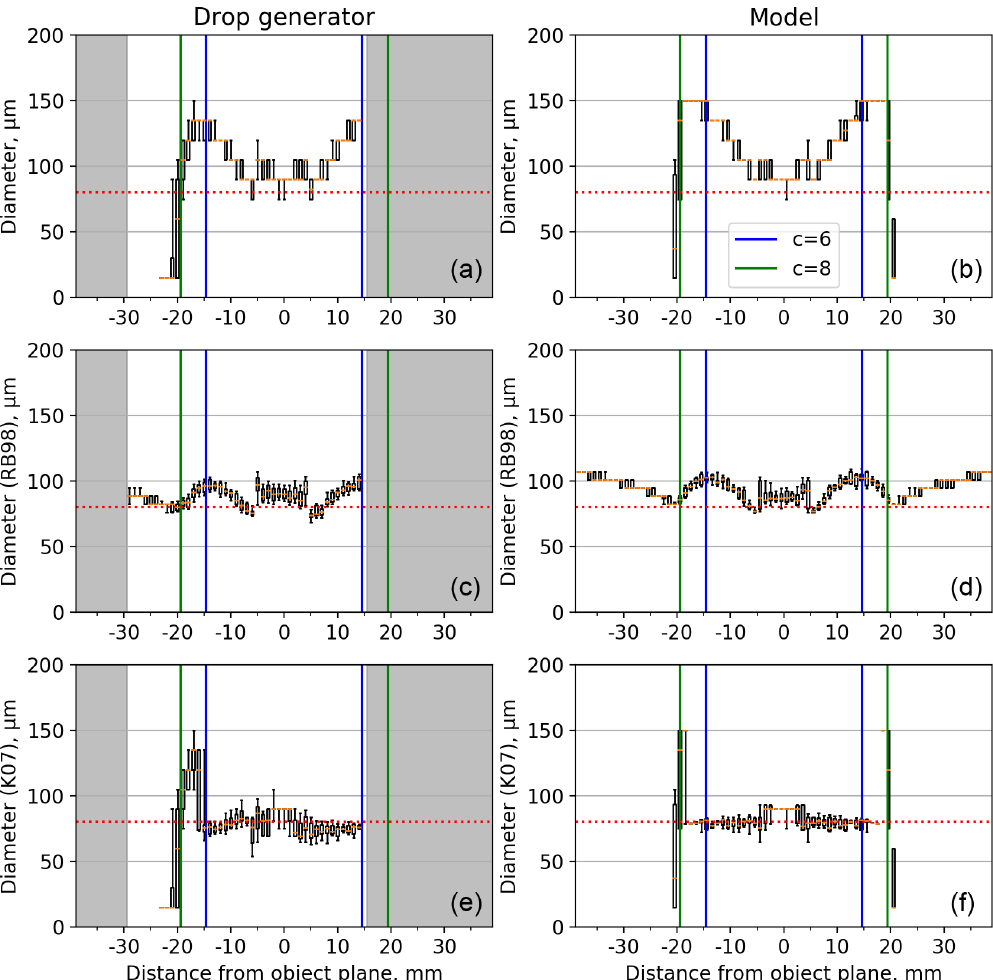
Figure 3. Same as Fig. 2 but panels (a) , (c) and (e) show results from the laboratory experiments using a 90µm printhead and panels (b) , (d) and (f) show the modelled image diameter from an 80µm